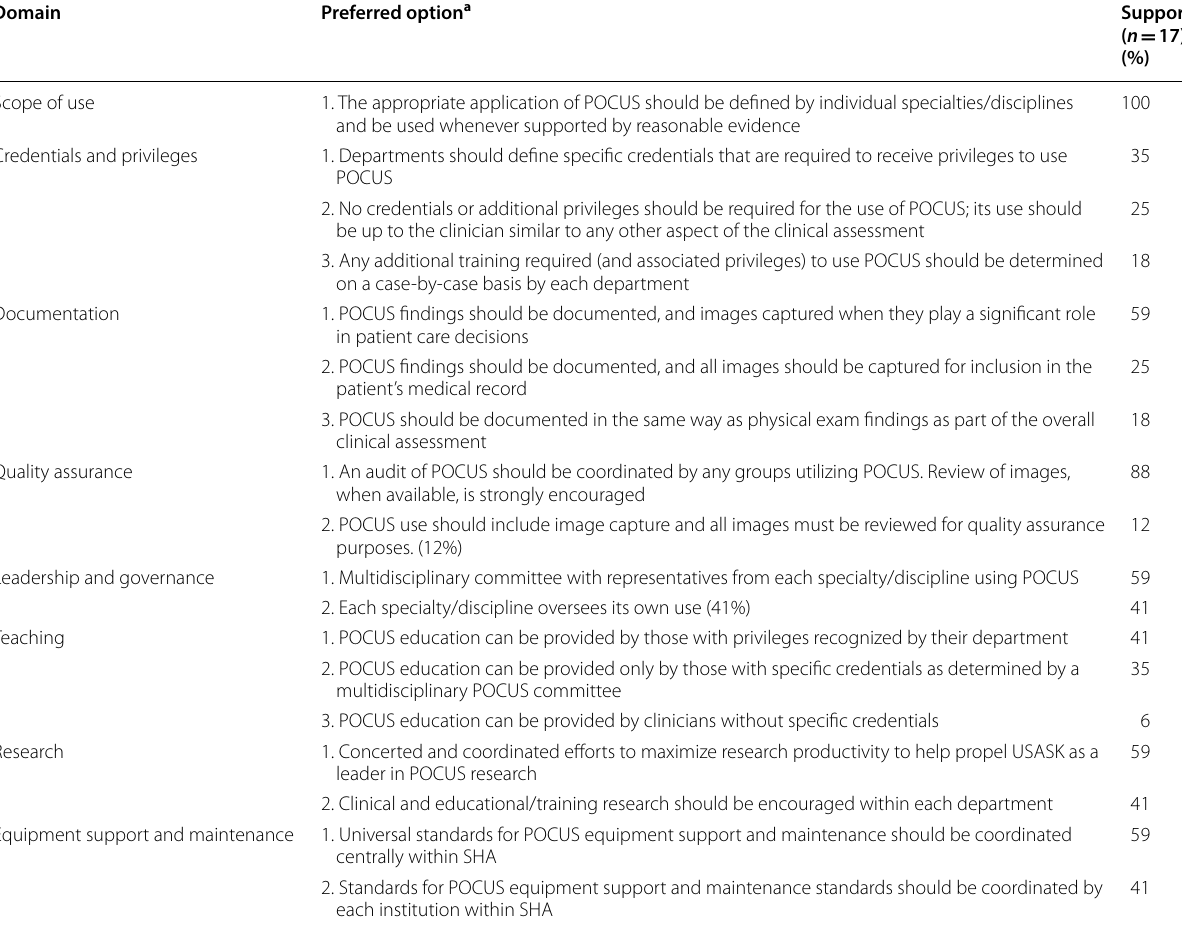
a Only potential standards which received at least one vote in support are included. The full set of potential standards is included in the survey in Additional file 1: Appendix S1